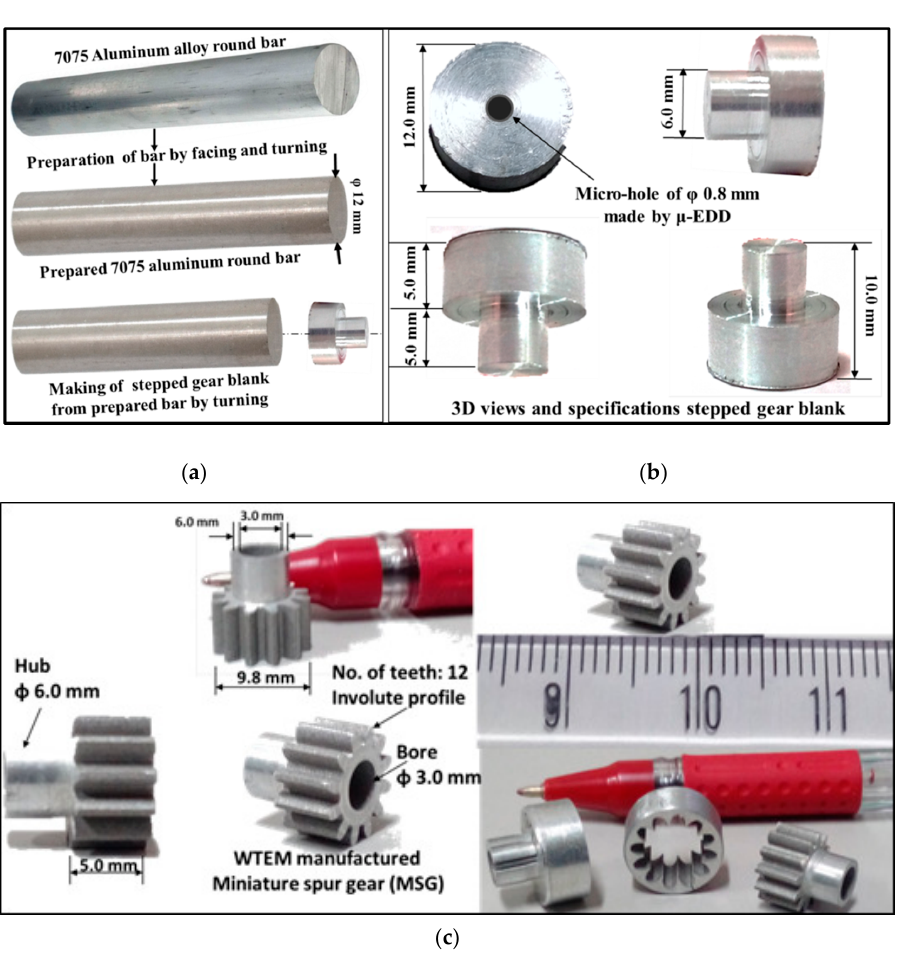
Figure 1. Procedure and specifications of: ( a ) 7075 aluminium alloy bar; ( b ) stepped gear blank; and ( c ) WTEM manufactured miniature spur gear with bore and hub.